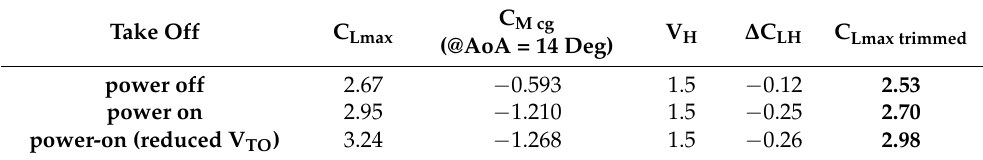
Table 18. Numerical results for take-off power-on condition, trimmed maximum lift coefficient, mo- ment coefficient calculated w.r.t. CG pos. (31% mac), V TO = 44 m/s and V TO = 51 m/s, Re = 5.7 × 10 6